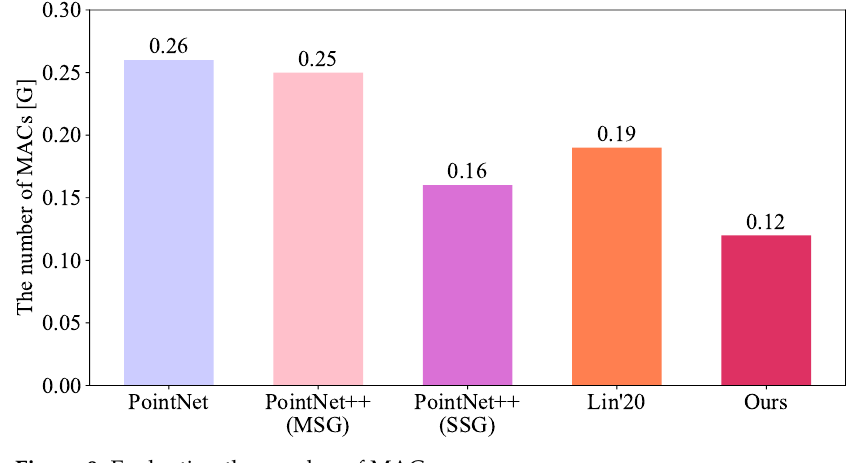
Figure 9. Evaluating the number of